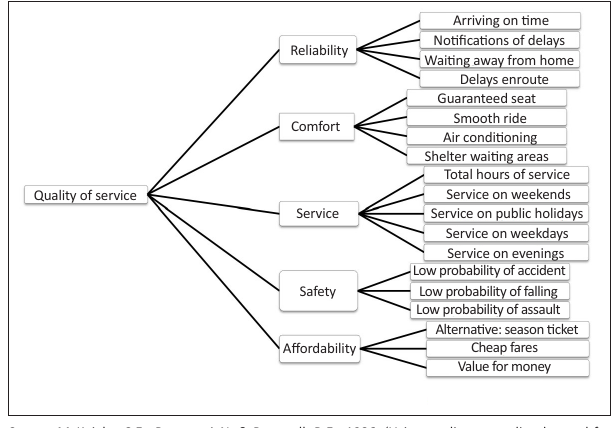
FIGURE 1: Service quality